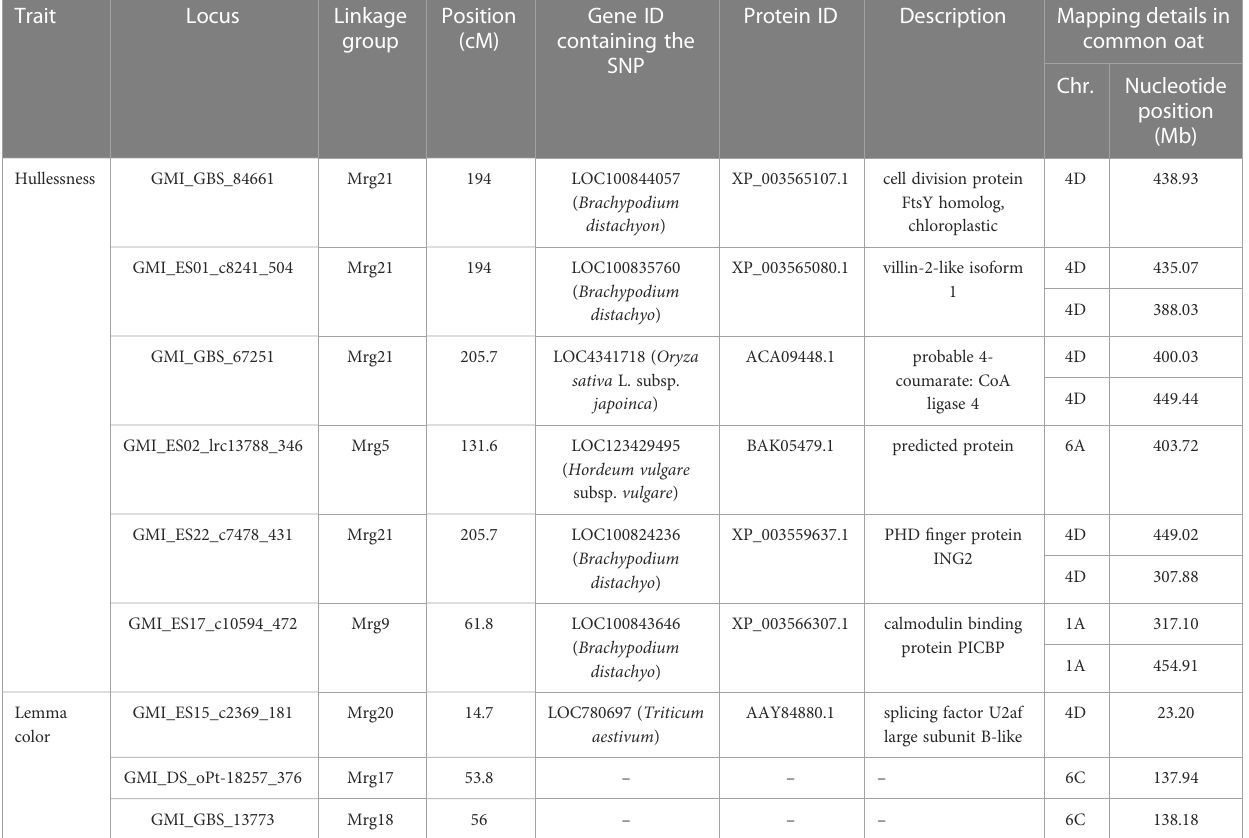
TABLE 4 Annotated genes located near signi fi cant SNP markers in a recently released genome assembly of common oat.